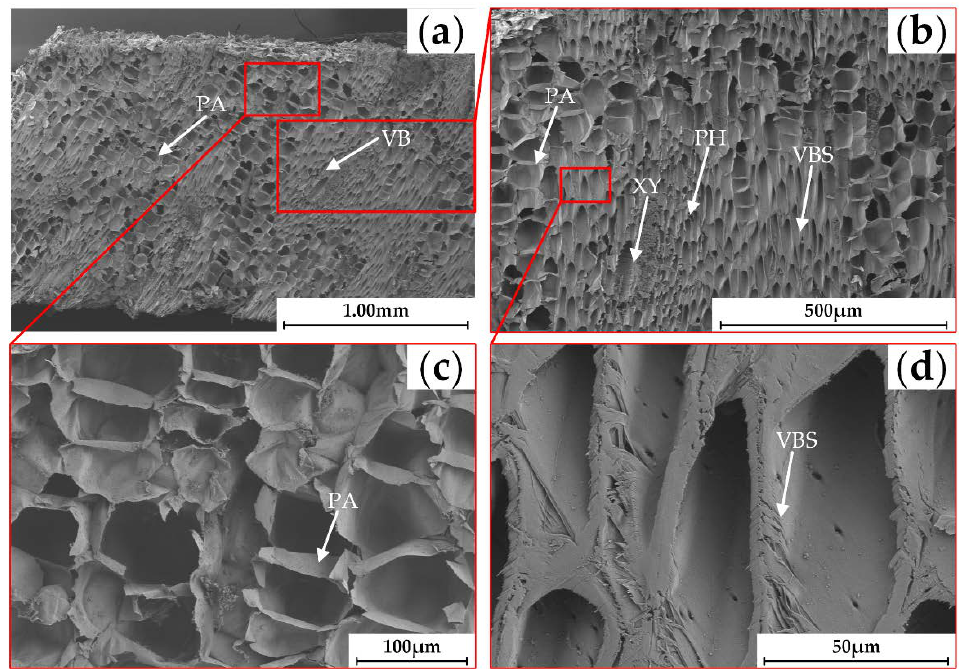
Figure 6. Crown slice longitudinal SEM images. ( a ) Is the image of the overall morphology of the slice; ( b ) and ( c ) are enlarged views of ( a ); ( d ) is obtained from the rectangular area of ( b ). PA = Parenchyma, PH = Phloem, VB = Vascular bundle, VBS = Vascular bundle sheath, XY = Xylem.